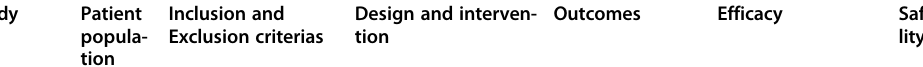
Table 4 Clinical trials of the traditional plants used for skin problems in Turkey (Continued) Study Patient popula-